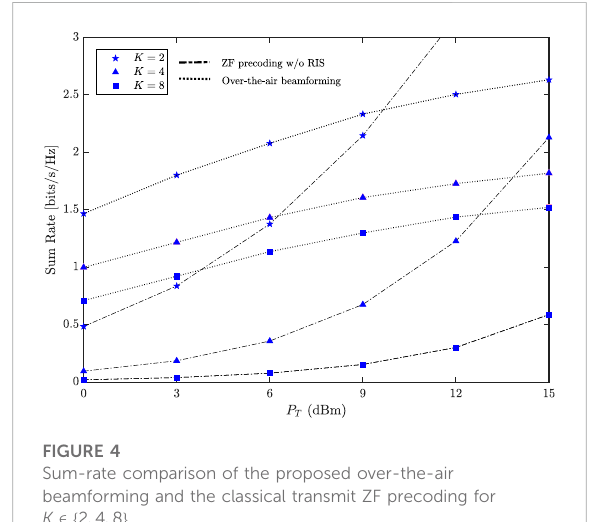
FIGURE 4 Sum-rate comparison of the proposed over-the-air beamforming and the classical transmit ZF precoding for K ∈ 2 , 4 , 8 { } .